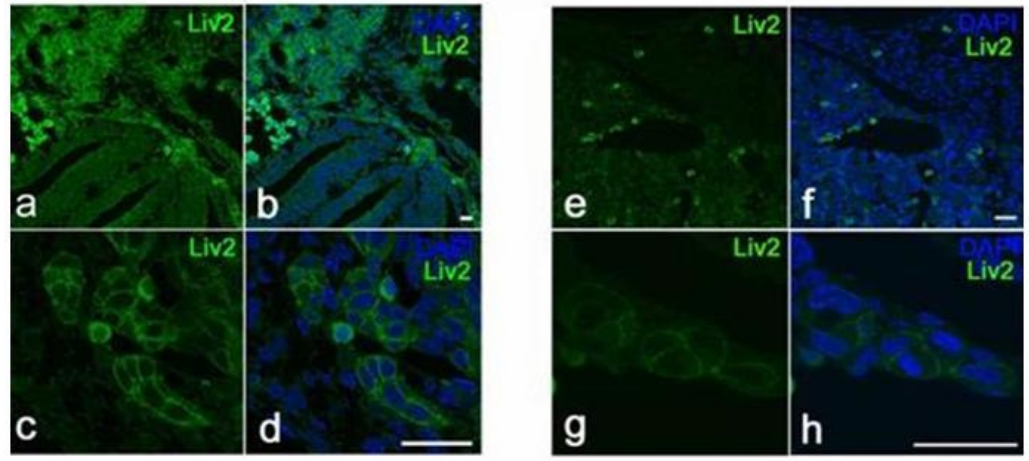
FIGURE 2 . Immunoreactivity for Liv2 (green) was observed in immature hepatocytes at stages from E9.5 (a–d) to E12.5 (e– h). Low magnification views of E9.5 embryo sections (a,b); high magnification (c,d); low magnification views of E12.5 embryo sections (e,f); their high magnification (g,h). The intensity of signals for Liv2 peaked at E9.5, and the signals were localized at the cell membrane and in particles close to the cell membrane. Immunoreactivity declined gradually from E12.5. The cells showing strong immunoreactivity throughout the whole cytoplasm by self-fluorescence were hemocytes. Bars = 20 µ m.